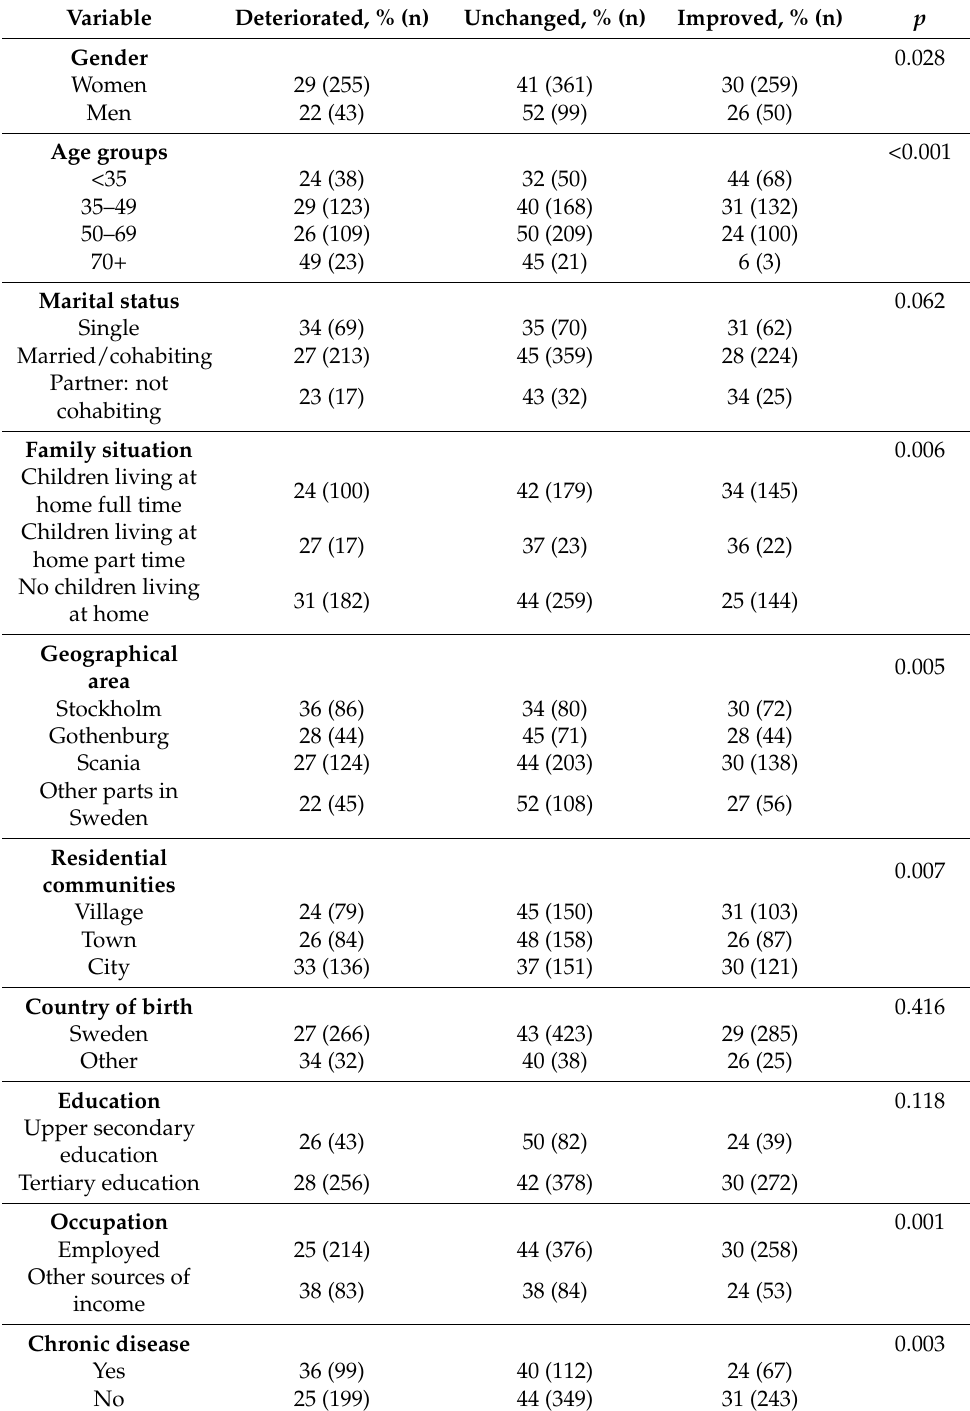
Table 4. Proportion of participants reporting changes in satisfaction with life as a